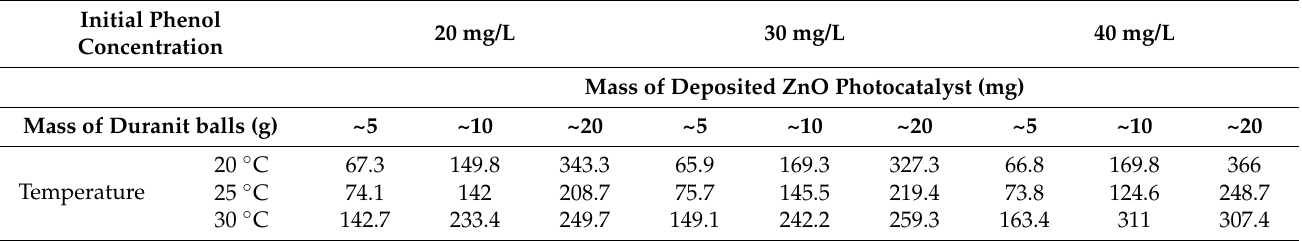
Table 3. 2nd cycle of photo-degradation batch tests.